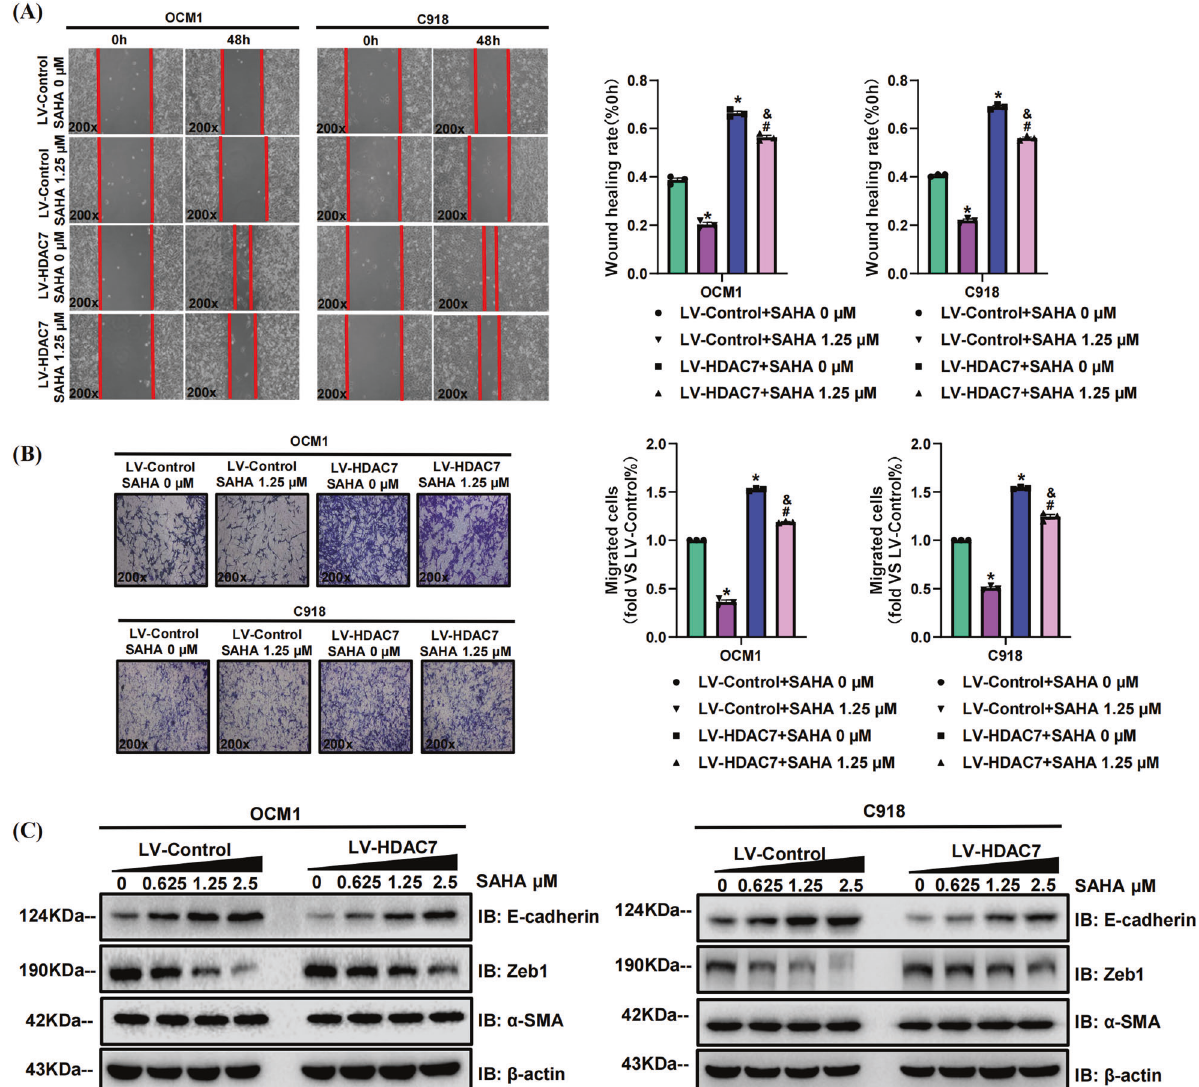
Fig. 5 SAHA suppresses HDAC7-mediated OCM1 and C918 cell metastasis. LV-Control and LV-HDAC7 OCM1/C918 cells were pretreated with SAHA for 48h. A Typical pictures (×200) and statistical analysis of the wound healing assay. In wound healing assays, the migratory capacity was shown as the mean scratch area. The initial scratch area (0 h) was set to 100%. B Typical pictures (×200) and statistical analysis of the transwell assay. C Typical Western blot results of HDAC7, E-cadherin, Zeb1, and α -SMA in LV-HDAC7 OCM1/C918 and LV-Control OCM1/C918 cells. β -actin was used as an internal control. Data are exhibited as the mean ± SD. Student ’ s t -test, * P < 0.05 vs. the LV-Control + SAHA 0 μ M group; # P < 0.05 vs. the LV-Control + SAHA 1.25 μ M group; & P < 0.05 vs. the LV-HDAC7 + SAHA 0 μ M group. Abbreviations: LV lentivirus, HDAC7 histone deacetylase